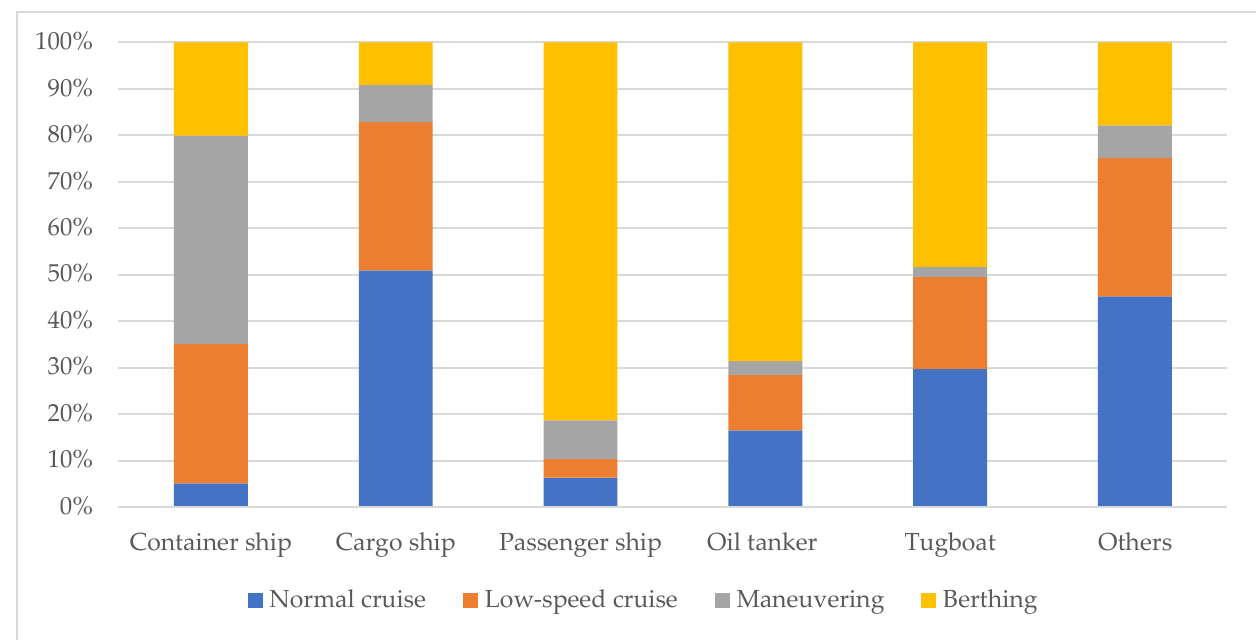
Figure 14. Comparison of PM 2.5 emissions in different sailing states.